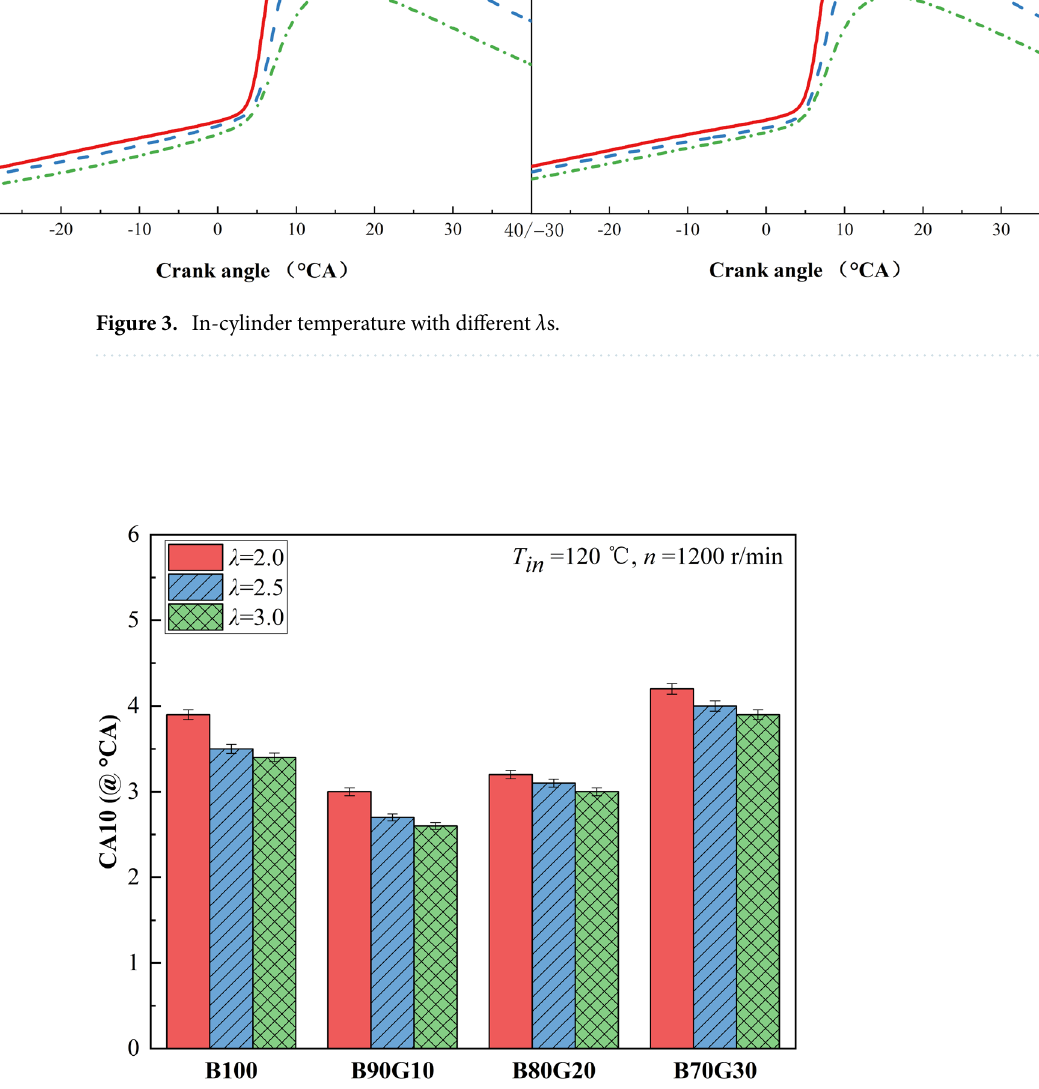
Figure 4. CA10 with different λ